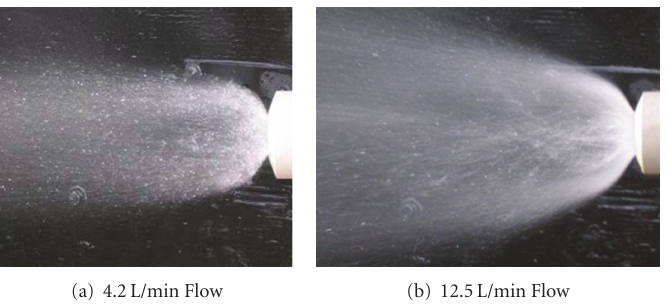
Figure 5: Visual droplet size comparison conditions corresponding to (a) 30% power and (b) 100% load.